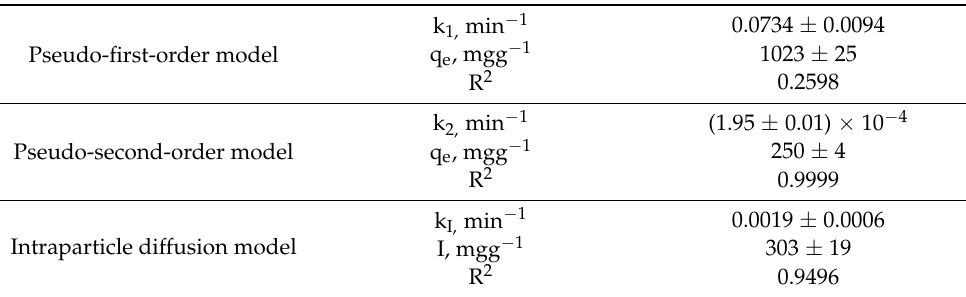
Table 3. Kinetic parameters of pseudo-first-order and pseudo-second-order models and the Weber– Morris intraparticle diffusion model for BSA on methionine-stabilized AgNPs ([BSA] 0 = 1 × 10 − 5 M, [AgNPs] = 1.27 mg L − 1 , T = 310 K, pH